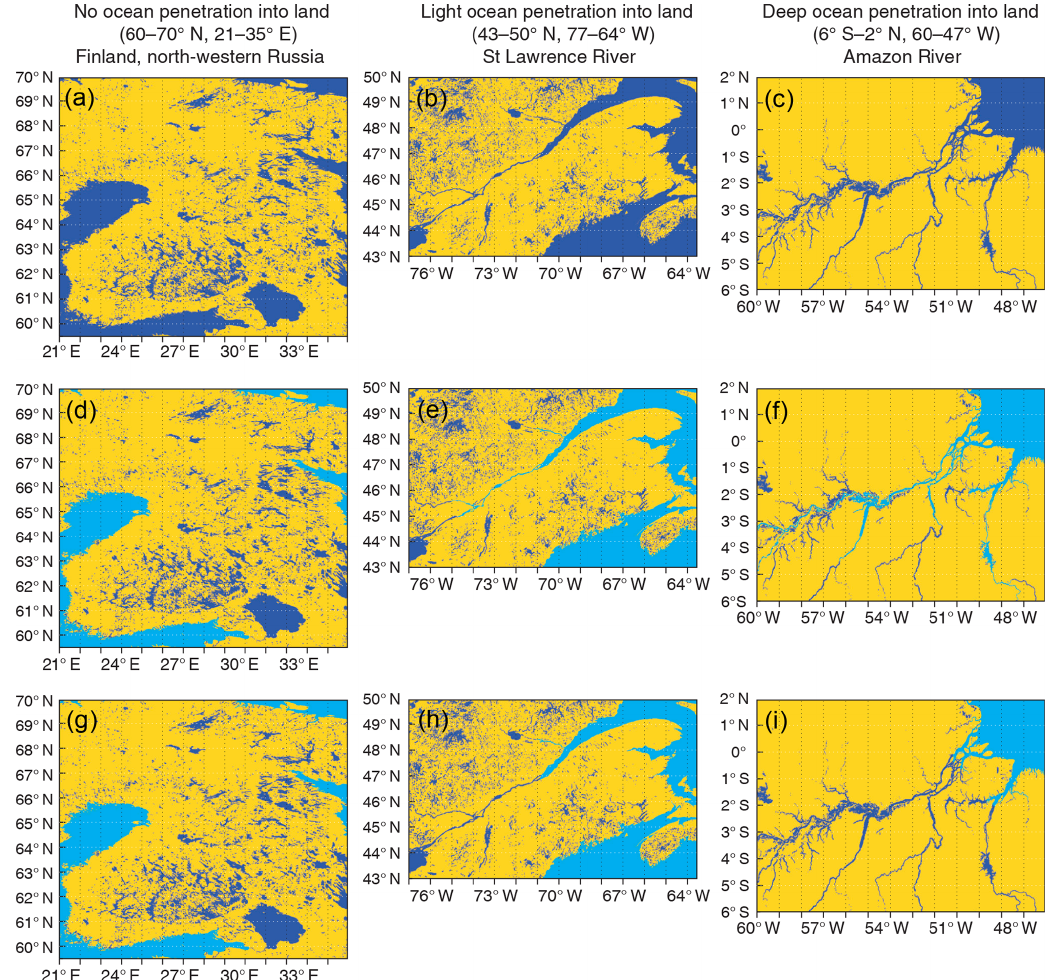
Figure 6. Phases of LWM water separation for Finland and the north-western part of Russia (a, d, g) , the St Lawrence River region (b, e, h) , and the Amazon River region (c, f, i) : no water separation (a–c) , separation with the flood-filling algorithm only (“basic” flooding, d–f ) and separation with flood-filling and newly developed pixel-by-pixel water separation algorithms (“extra” flooding, g–i ); yellow colour indicates land, dark blue indicates inland water (in d–f and g–i ) or total water (in a–c ), and light blue indicates